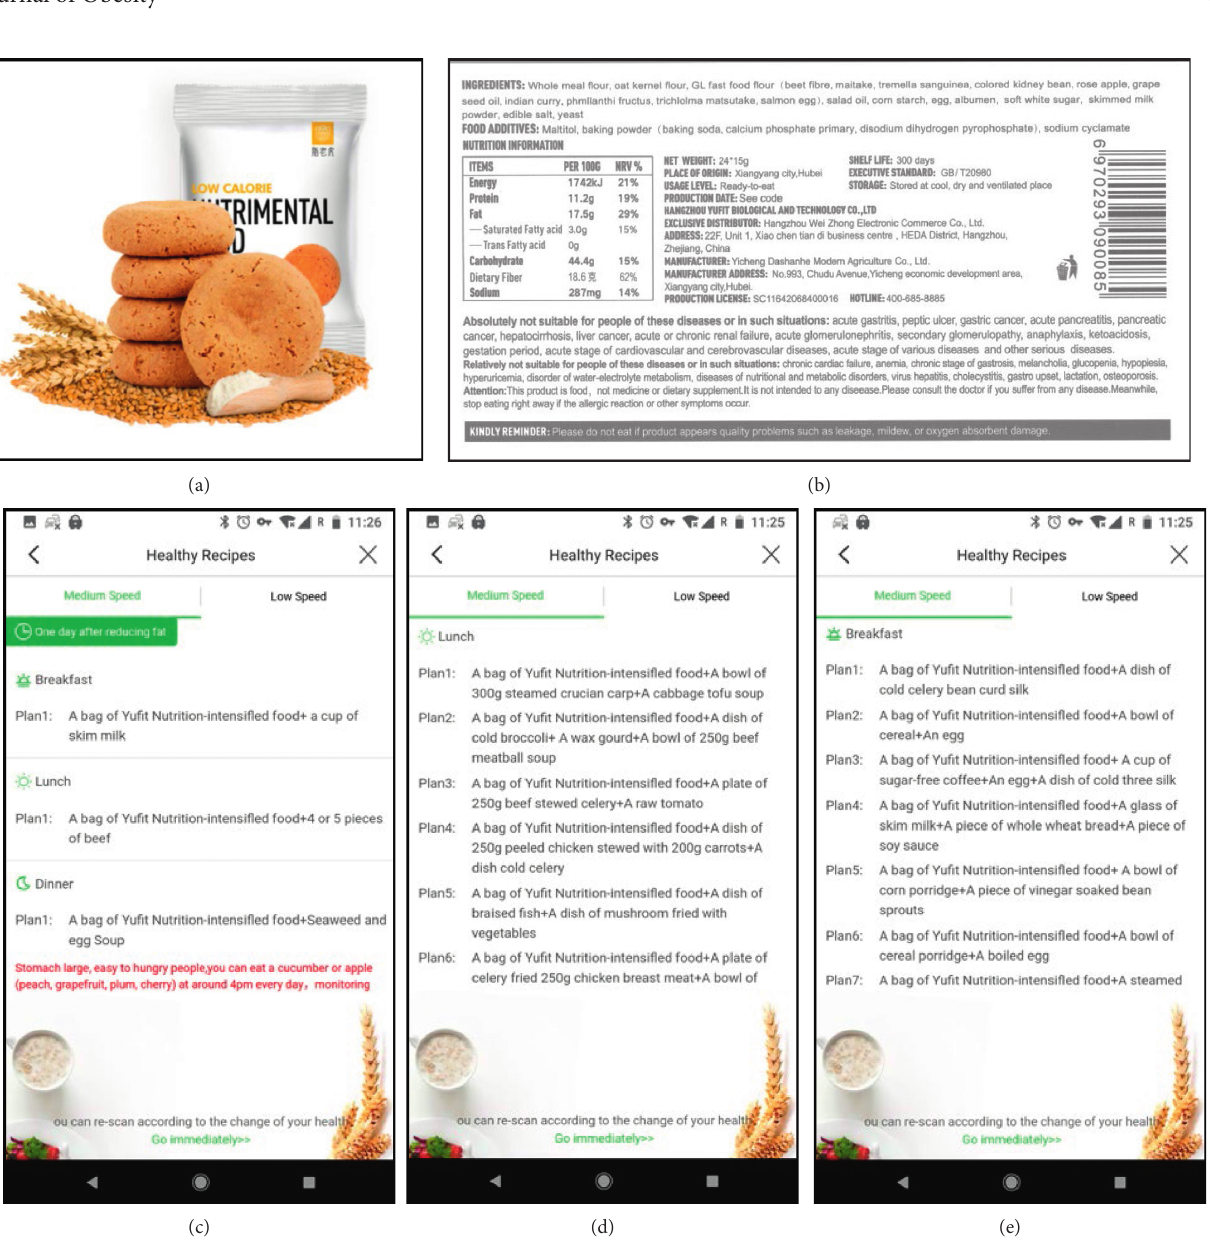
Figure 1: Nutritional Program. (a) Meal replacement biscuit. (b) Nutritional information provided on meal replacement packaging. (c) Daily summary of nutritional plan. (d) Lunch meal options. (e) Breakfast meal